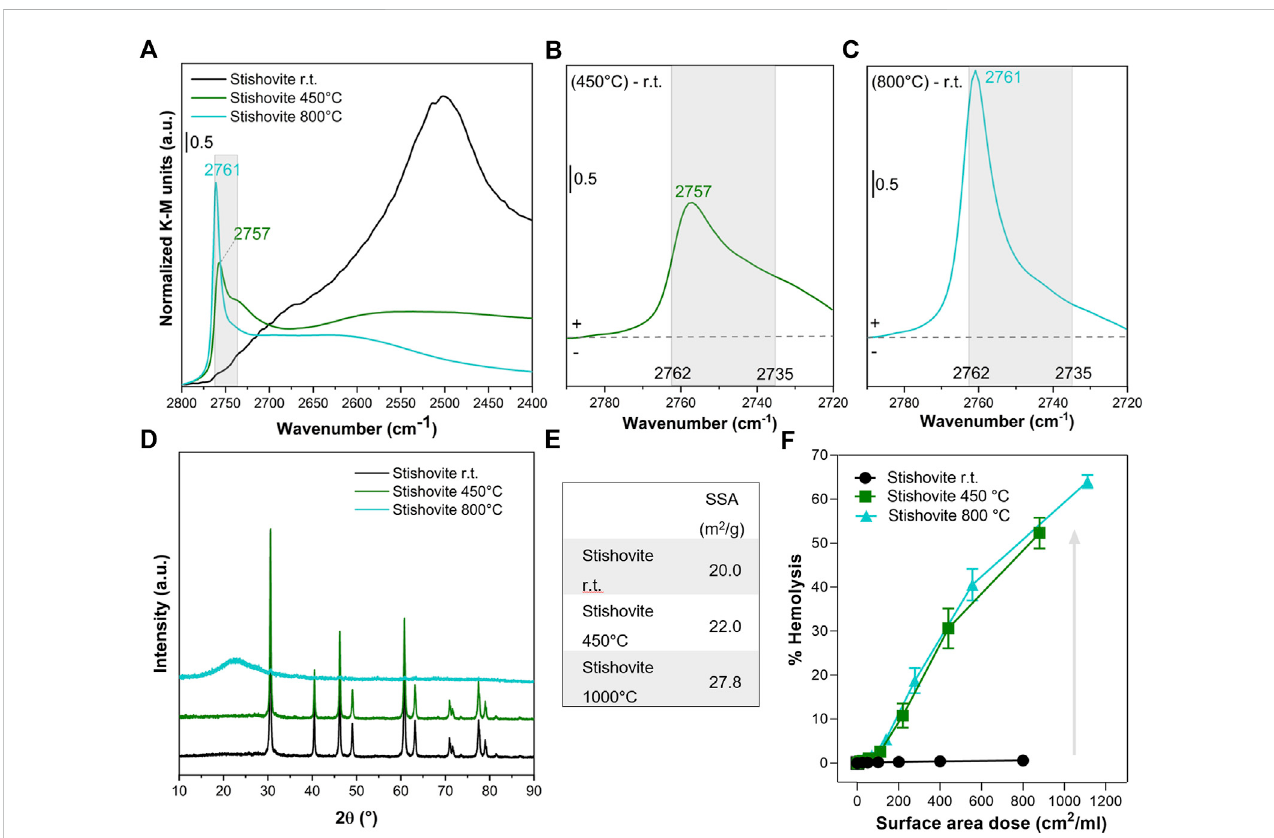
FIGURE 4 Nearlyfreesilanols(NFS)determinethemembranolyticactivityofstishovite.Pristinestishoviteparticles(i.e.,roomtemperature,r.t.)werecalcinedat450 ° and 800 ° C. (A) Surface silanol distribution measured by DRIFT spectroscopy after H/D exchange in the ν OD spectral region. (B,C) Differences in silanol population between stishovite calcined at 450 ° C and pristine (B) or stishovite calcined at 800 ° C and pristine (C) . Spectra are centered to the ν OD spectral region assigned to NFS (2,762 – 2,735 cm − 1 ) and isolated silanols. (D) XRPD patterns. (E) Speci fi c surface area evaluated by BET method with N 2 adsorption. (F) Membranolyticactivity(percenthemolysis)ofparticlesthat wereincubatedfor30 minwithpuri fi edsheepRBCs.Dataarereportedpersurface area dose and are mean ± SEM of three independent